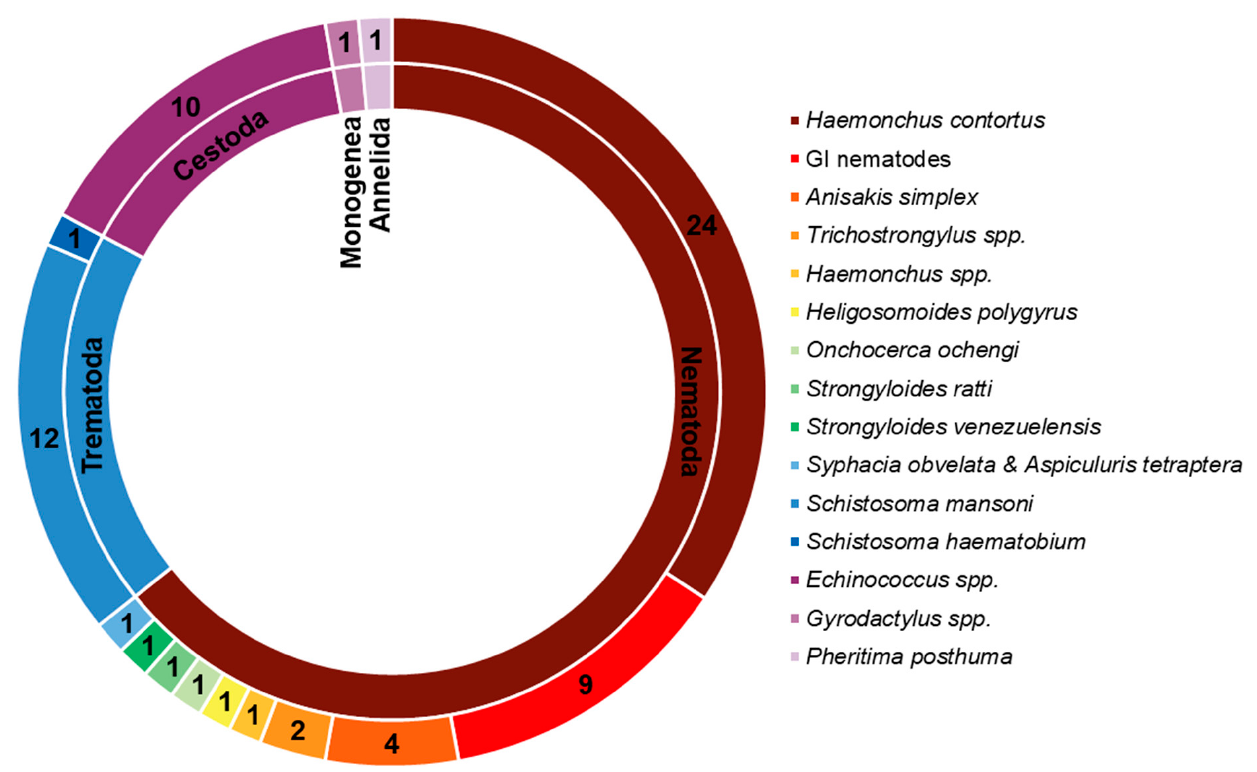
Figure 4. Distribution of different anthelminthic assay methods in in vitro and in vivo experi ‐ ments.